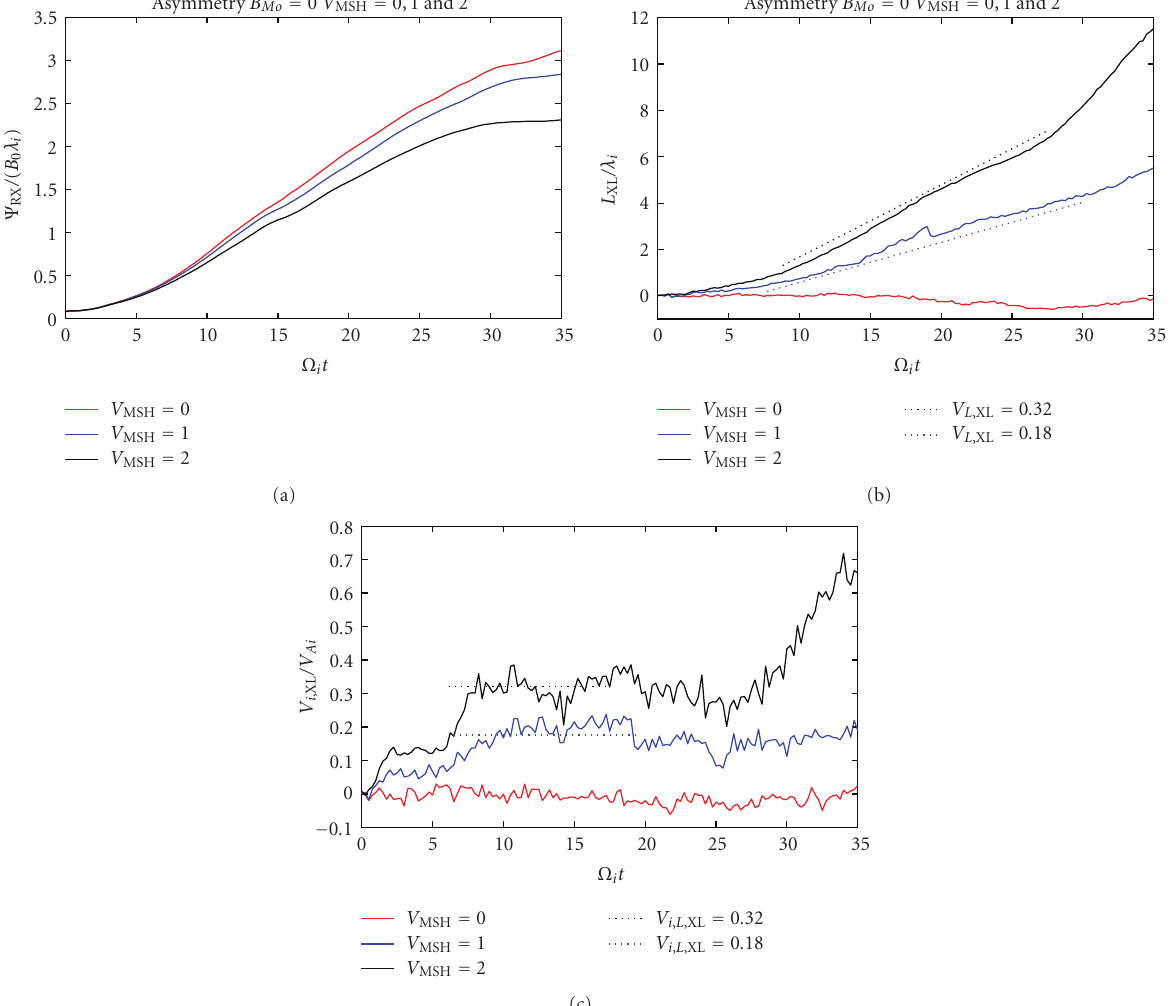
line depicts the location of the X-line N XL (determined in Panel b). In Panel (c), while the ion stagnation point is located between − 1 < N < − 0 . 5, it is clear that the ion stagnation point is more to the magnetospheric side than the